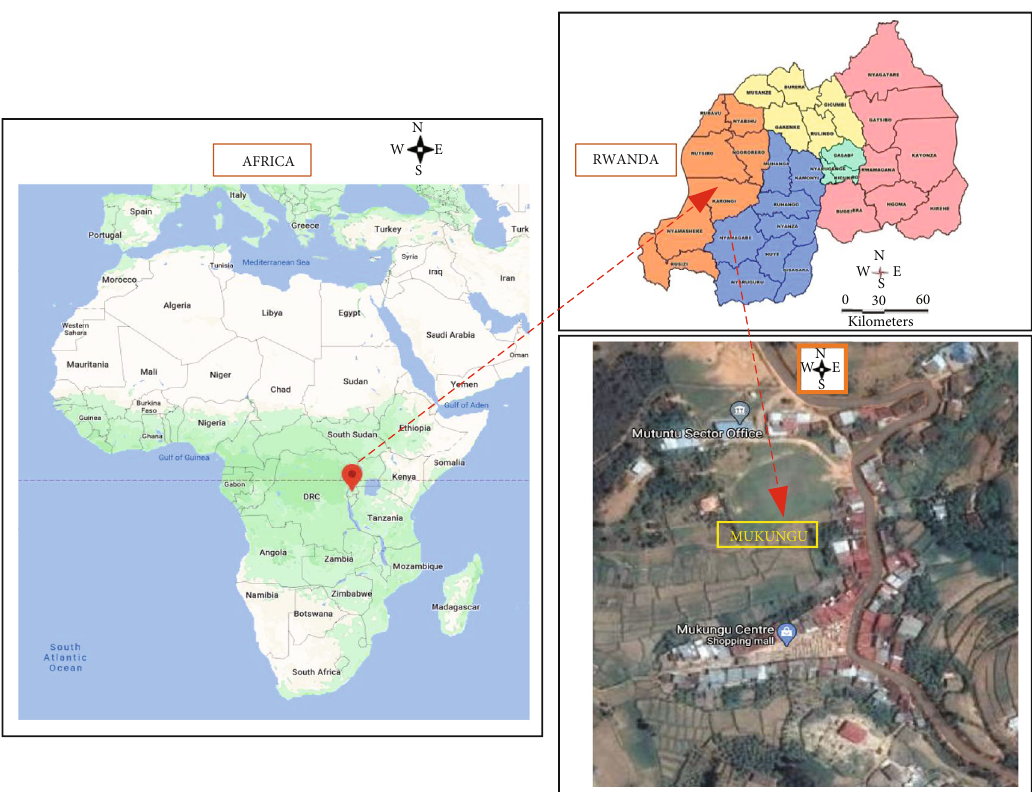
Figure 3: Location map of the selected study area (Mukungu village).